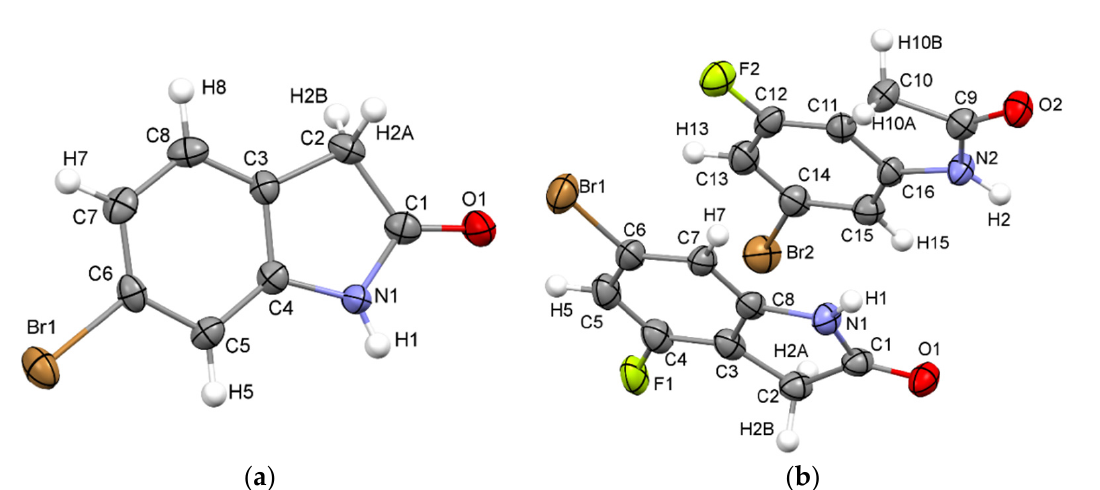
Figure 1. Numbered thermal ellipsoid diagrams (50% probability) of structure 1 ( a ) and structure 2 ( b ). Examination of the short atomic intermolecular features of 1 and 2 reveals similar Table 1. X-ray Crystal data and refinement parameters for Structures 1 and 2. hydrogen-bonding motifs but unique interactions involving the halogen atom contacts. Details of short intermolecular contacts can be found in Table